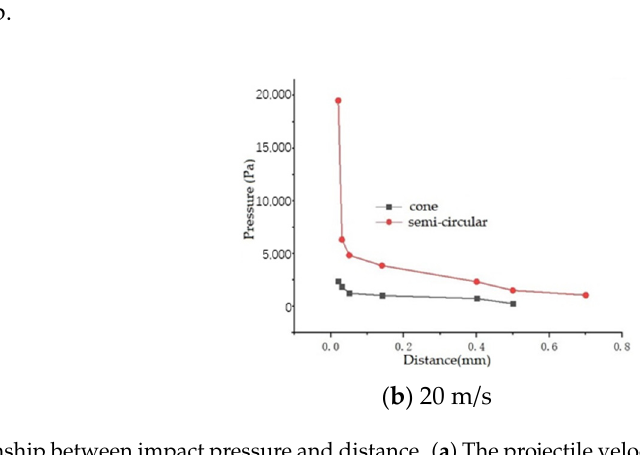
Figure 6. The relationship between impact pressure and distance. ( a ) The projectile velocity of 10 m/s. ( b ) The fixed projectile velocity is constant at 20 m/s.